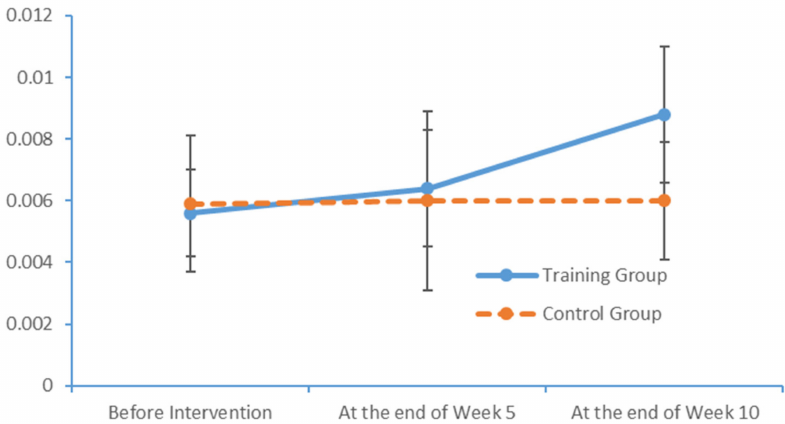
Figure 11. Changes in the power values of the alpha_region_front wavebands measured in the two subject groups at several time points.